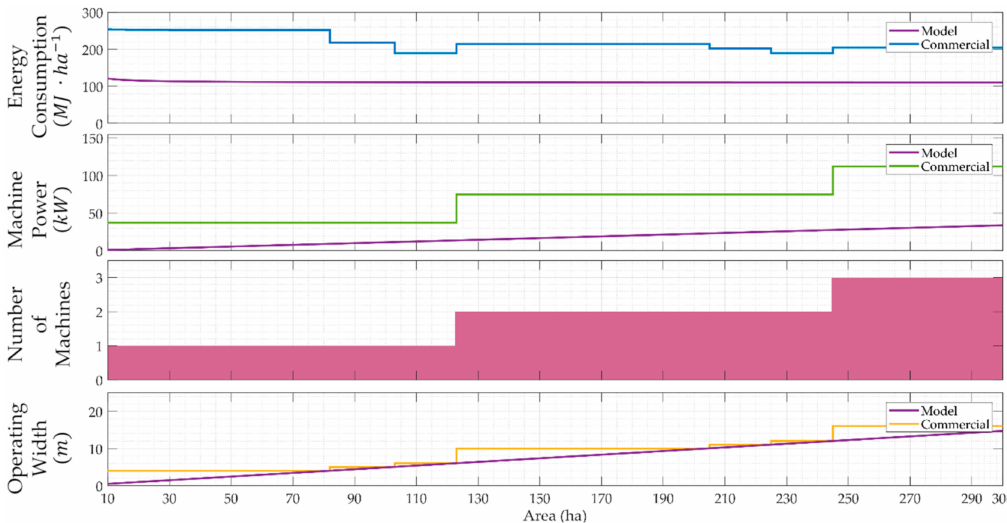
Figure 4. Energy consumption, machine power, number of machines, and operating width for 30 h time available (field cultivator).